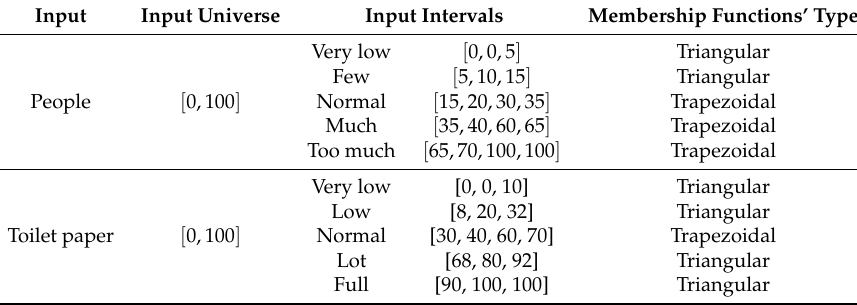
Table 8. Definitions of input membership